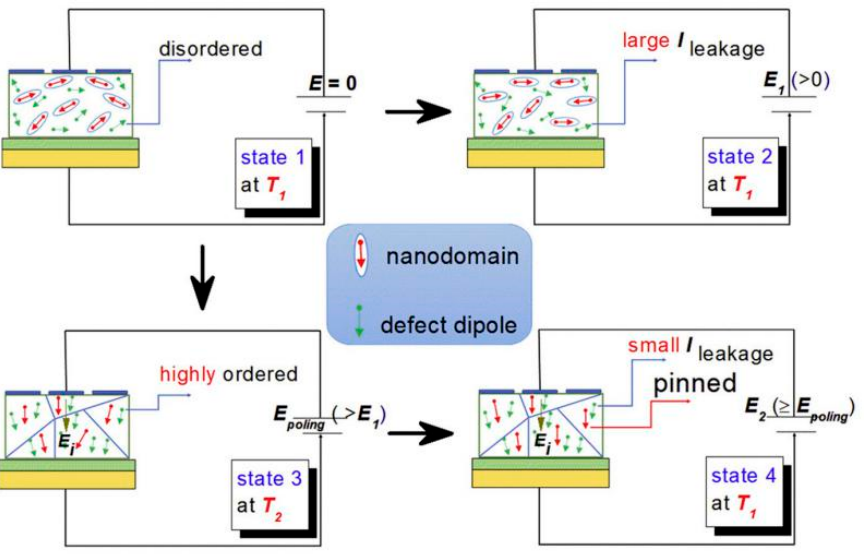
Figure 19. Model diagram of low temperature polarization increasing dielectric breakdown electric field. Reprinted with permission from [65]. Copyright 2020 Published by Elsevier Ltd.